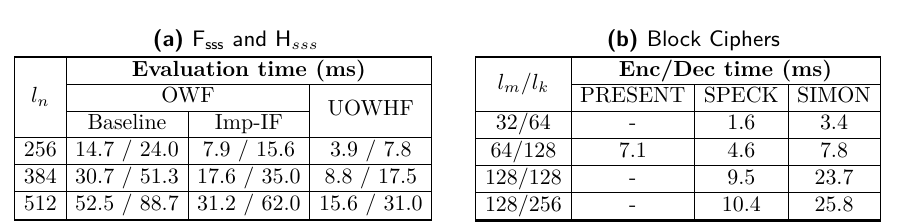
Table 5: Runtimes of F sss , H sss and Block